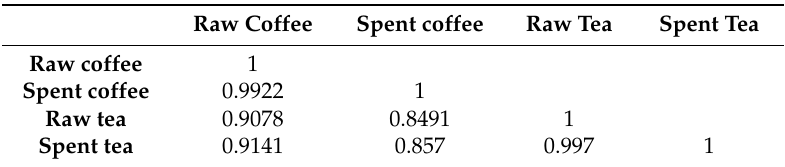
Table 1. Correlation coefficient ( R 2 ) between the antioxidants parameters in the raw and spent coffee and black